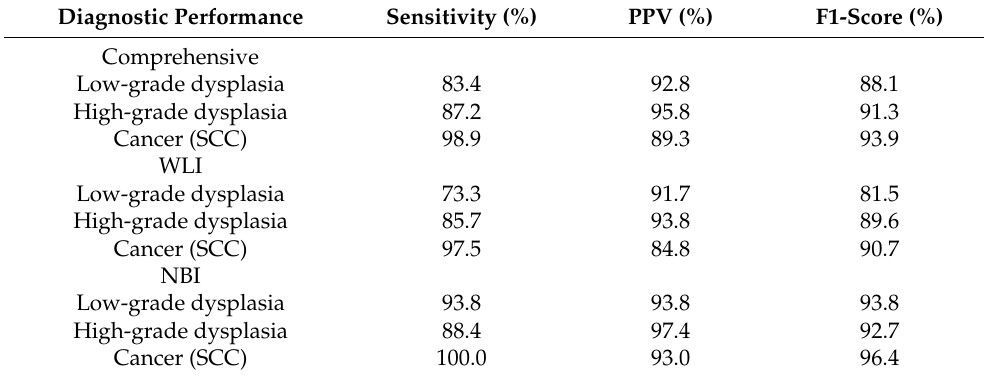
Table 4. Diagnostic performance of SSD for different histological grades of esophageal